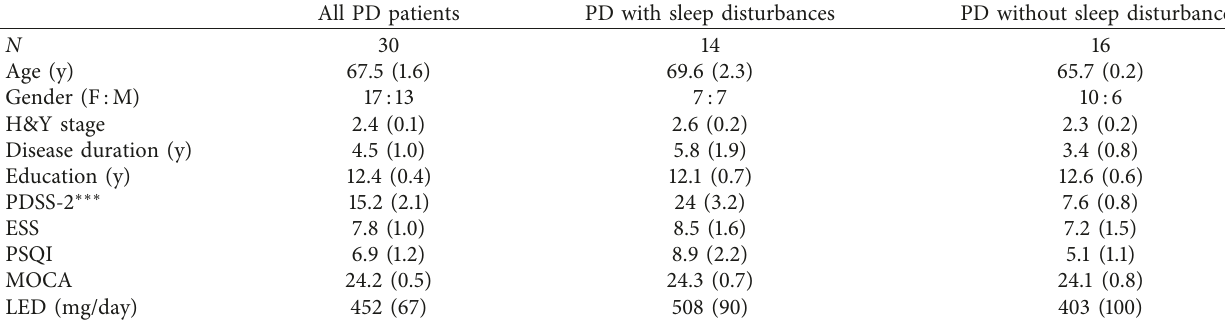
Table 1: Demographics of Parkinson’s disease patients with/without sleep disturbance according to PDSS-2, ESS, and PSQI scores. All PD patients